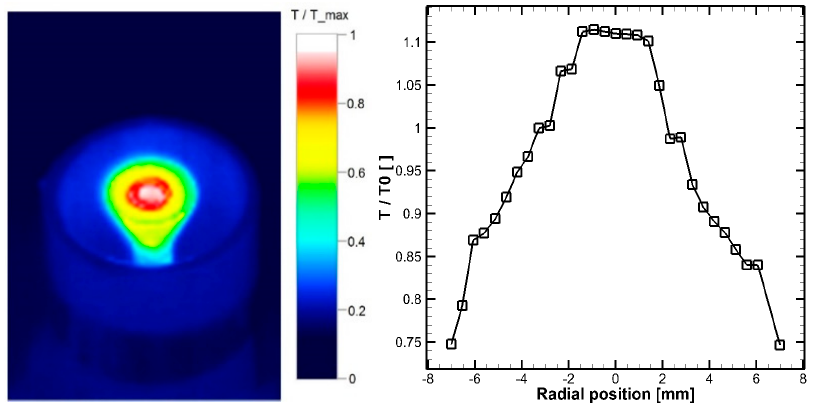
Figure 3. Typical infrared image ( left ) and temperature ratio along the radius direction ( right ).